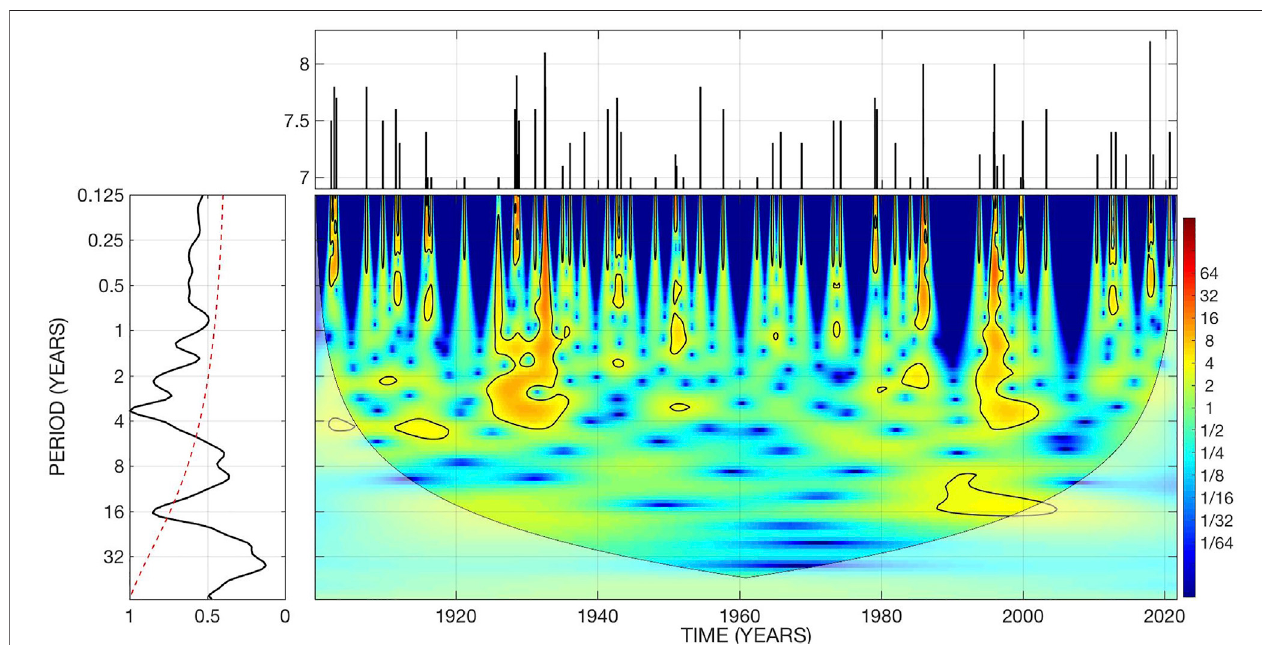
FIGURE 5 | Results of the time-frequency wavelet spectral analysis of earthquake time series record ( M ≥ 7) for the southwestern Mexico seismic zone between 1900 and 2021. The global time-averaged wavelet period (left panel) with the red dashed line indicatingthe 95% con fi dence level drawn from a red noise spectrum. The Morlet wavelet power spectral density (MWPSD) in arbitrary units adopting the red-green-blue colour scales (central panel). The cone of in fl uence shows the possible edge effects in the MWPSD (i.e., the U-shaped curves outside of which the spectral information can be considered unreliable).